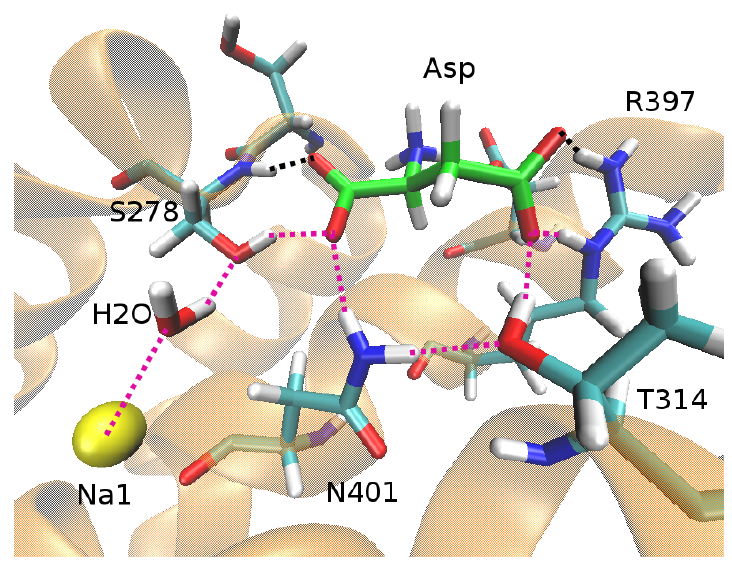
Figure 3. The binding pocket of Glt in the open state of the outward-facing conformation, Ph showing the hydrogen-bond network ( purple dotted lines ) that couples Na1 ( yellow sphere ) to Asp ( green backbones